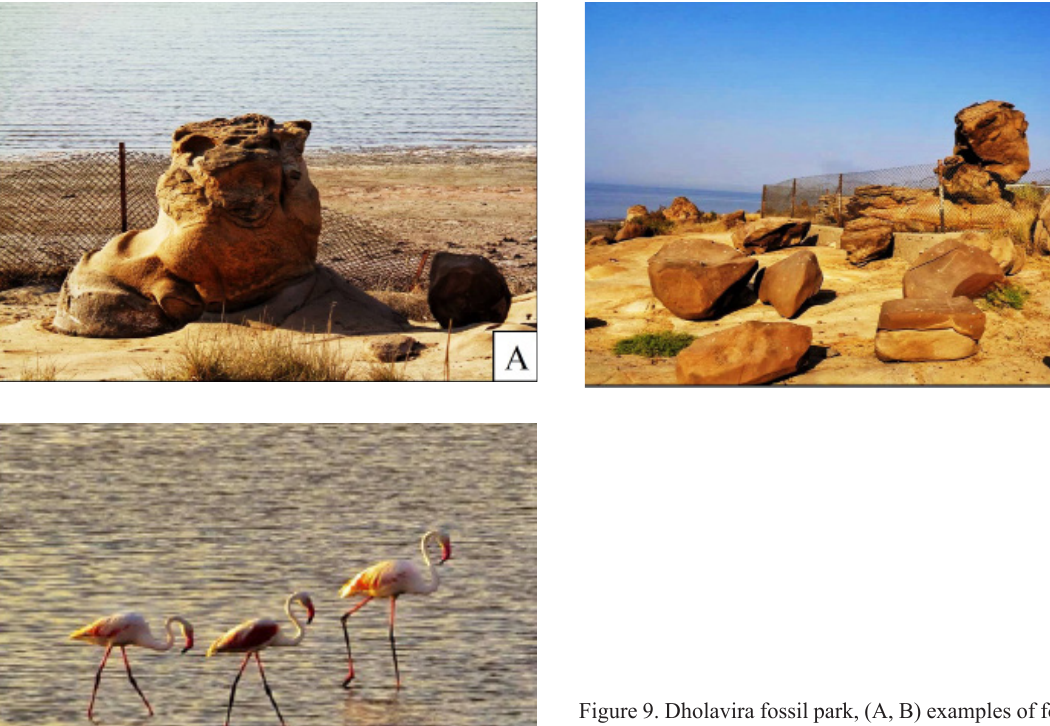
Figure 9. Dholavira fossil park, (A, B) examples of fossil tree trunks; C) flamingos in lake near Dholavira Fossil Park.